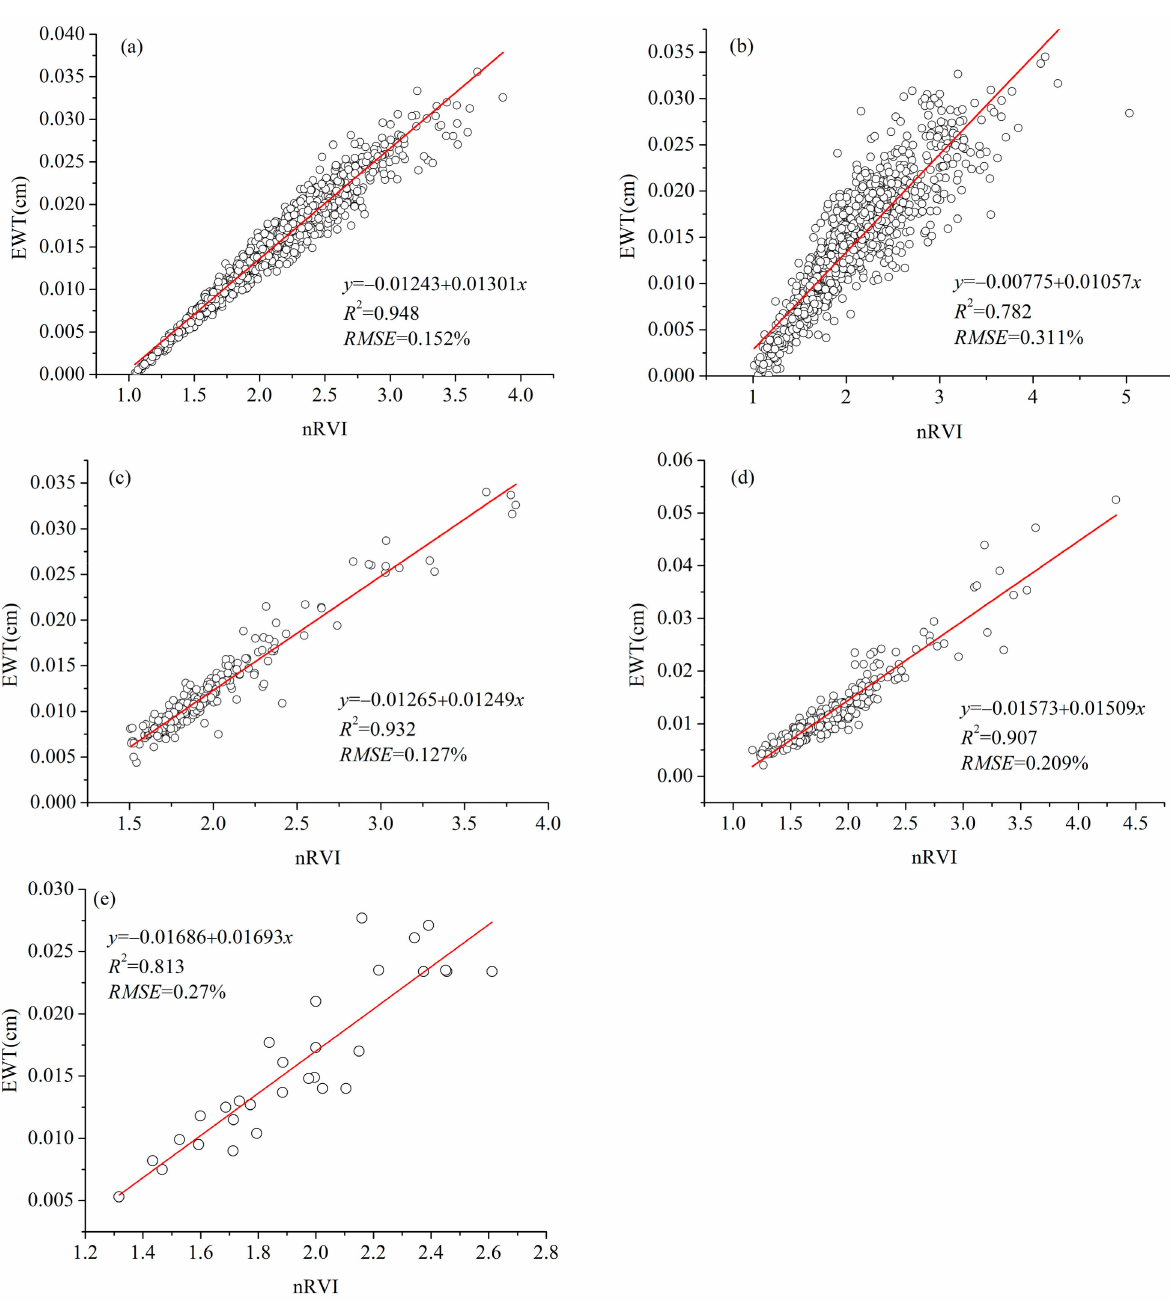
Figure 5. Correlations between EWT and nRVI for the different datasets: ( a ) synthetic spectrum without noise, ( b ) synthetic spectrum with 2% random Gaussian noise, ( c ) ANGERS, ( d ) LOPEX, and ( e )